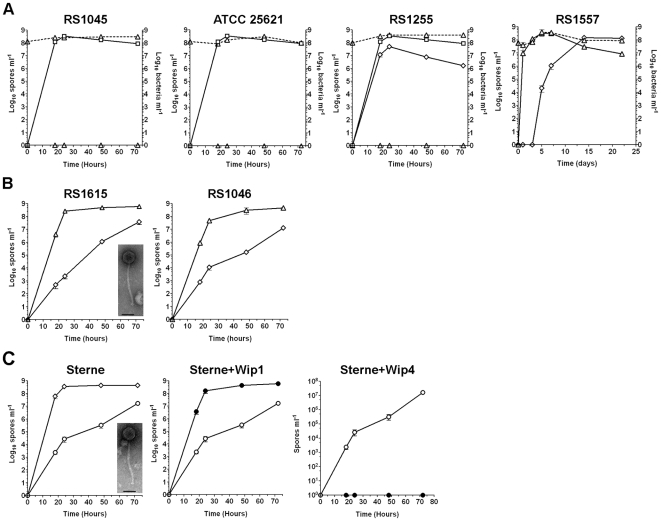
Sporulation phenotypes of natural B. cereus s.l. lysogens.Kinetic analyses of sporulation were performed in LD medium. All values are mean averages (n = 3) and error bars are standard deviations. (A) Sporulation of environmental B. cereus. Total viability (dashed lines) and spores alone (solid lines) are shown for growth conditions that include 37°C at 180 rpm (RS1045 and ATCC 25621), 30°C at 180 rpm (RS1255) or 24°C at 75 rpm (RS1557). B. anthracis ΔSterne (squares), the indicated environmental isolates (triangles), and phage-cured variants RS1255CURED and RS1557CURED (diamonds) are shown. (B) Sporulation for environmental B. anthracis strains. Cultures were grown at 37°C and aerated at 180 rpm. Strains include RS1615 or RS1046 (triangles) and RS1615CURED or RS1046CURED (diamonds). An electron micrograph of the inducible phage from RS1615 is shown (scale bar in 50 nm). (C) Sporulation for B. anthracis Sterne. Cultures were grown at 37°C and aerated at 180 rpm. Included are Sterne (circles), SterneCURED (diamonds), and the Wip1 or Wip4 lysogens of Sterne (closed circles). An electron micrograph shows the inducible Sterne phage (scale bar is 50 nm).